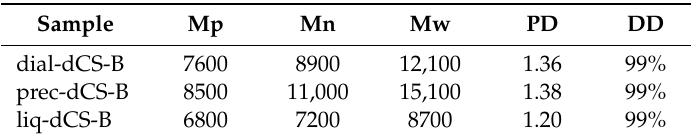
Table 6. GPC analysis of the dCS-B fractions obtained from the dialysis and lyophilization or from centrifugation prior to dialysis.